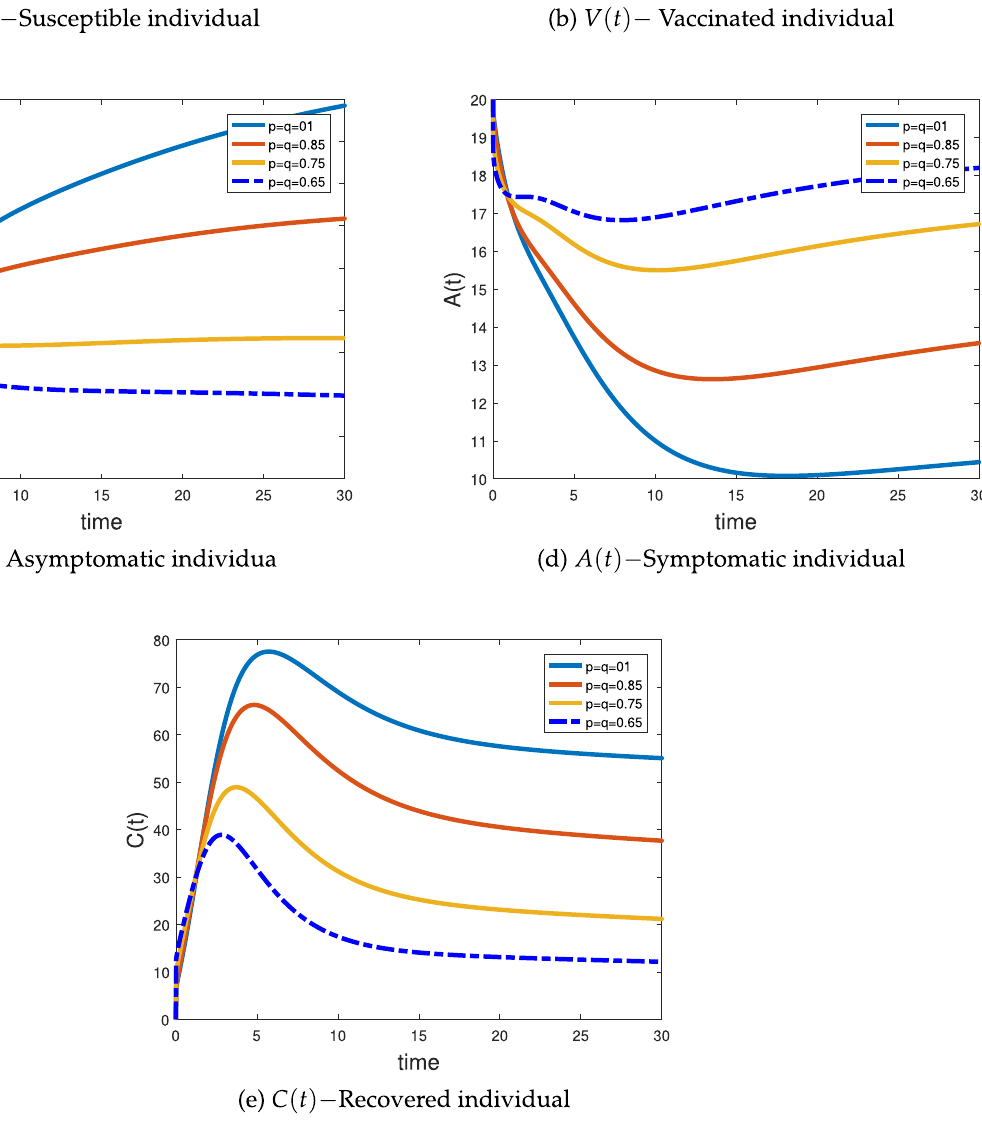
Figure 6. Simulations of the fractional-fractal NoV model in ABC case of system (36) when p = q = ( 01, 0.85, 0.75, 0.65 )